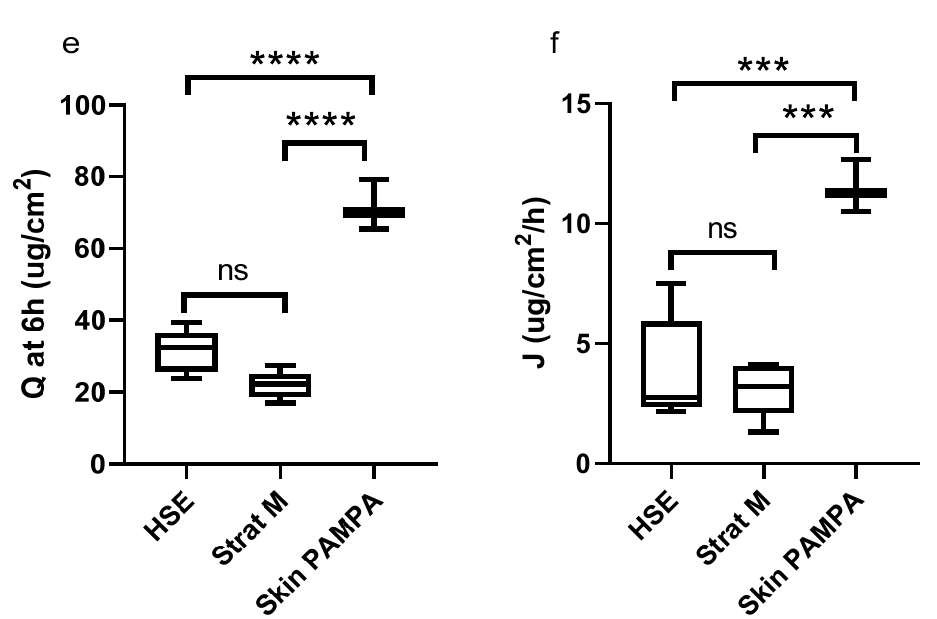
Figure 4. Box plot of the permeation parameters with different membranes in the case of HG2 ( a , b ); o/w ( c , d ), and w/o ( e , f ) formulation. (** p < 0.01, *** p < 0.001, **** p < 0.0001, ns: no significance).